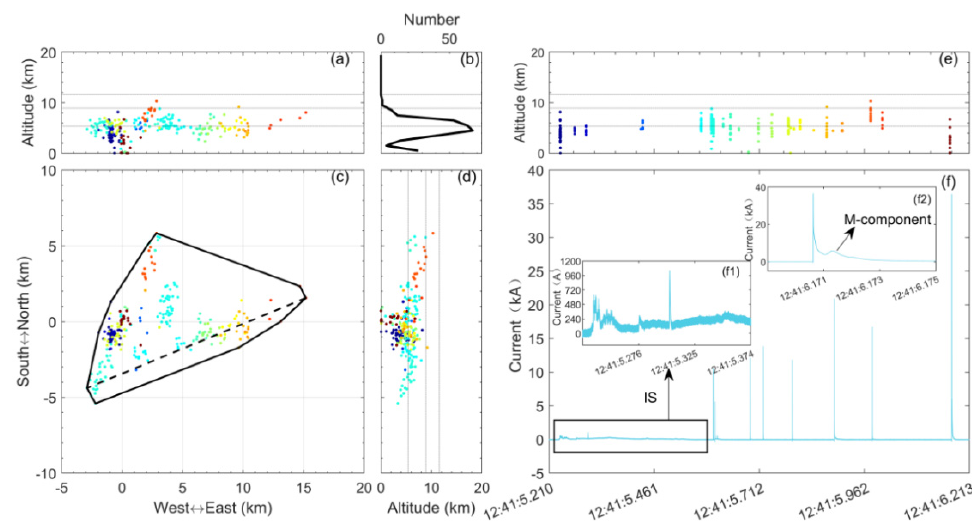
Figure 3. LFEDA sources and current of a TLF on 11 June 2019 12:41:02 (named T20190611124102, the same as below). ( a ): East–west vs. height view of the sources; ( b ): Number of sources with height in 1 km bins; ( c ): Plan view of the sources; ( d ): South–north vs. height view of the sources; ( e ): Height of the sources with time; ( f ): Current with time. The change in the color of sources from blue to red corresponds to the time sequence. The black polygon in ( c ) is a convex hull that delineated all the sources with the smallest area. The dotted line in ( c ) indicates the lightning length, which is defined as the farthest distance between any two sources in a horizontal plane. The subgraphs marked as ( f1 , f2 ) in ( f ) amplify the currents of the initial stage and the last return stroke-containing subsequent M-component process. The dotted lines in ( a , b , d , e ) indicate 0, − 20, and − 40 ◦ C ambient temperatures, respectively, from bottom to top.